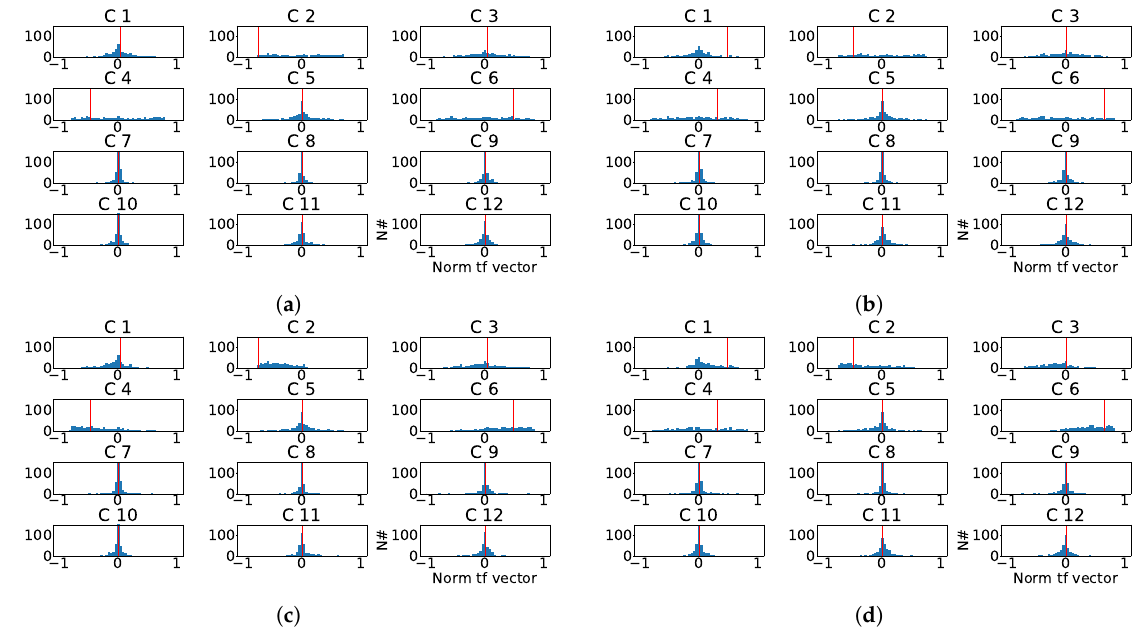
Figure 22. Distribution of the normalized ICA transformation matrix for the last principal component of the twelve-lead model. ( a ) Distribution of the transformation matrix components for each control patient. ( b ) Distribution of the transformation matrix components for each subrogated fragmented patient. ( c ) Aligned distribution of transformation matrix components for each control patient. ( d ) Aligned distribution of transformation matrix components for each subrogated fragmented patient. The red line shows the value of transformation vector used in the